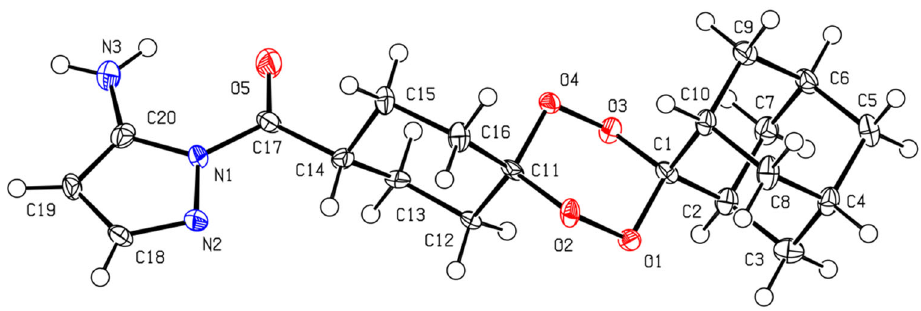
Figure 2. ORTEP drawing of the molecule of (5 ‐ amino ‐ 1H ‐ pyrazol ‐ 1 ‐ yl) (dispiro[cyclohexane ‐ 1,3’ ‐ [1,2,4,5]tetraoxane ‐ 6’,2’’ ‐ tricyclo[3.3.1.1 3,7 ]decan] ‐ 4 ‐ yl) ‐ methanone (T1 ). Displacement ellipsoids are drawn at the 50% probability level.